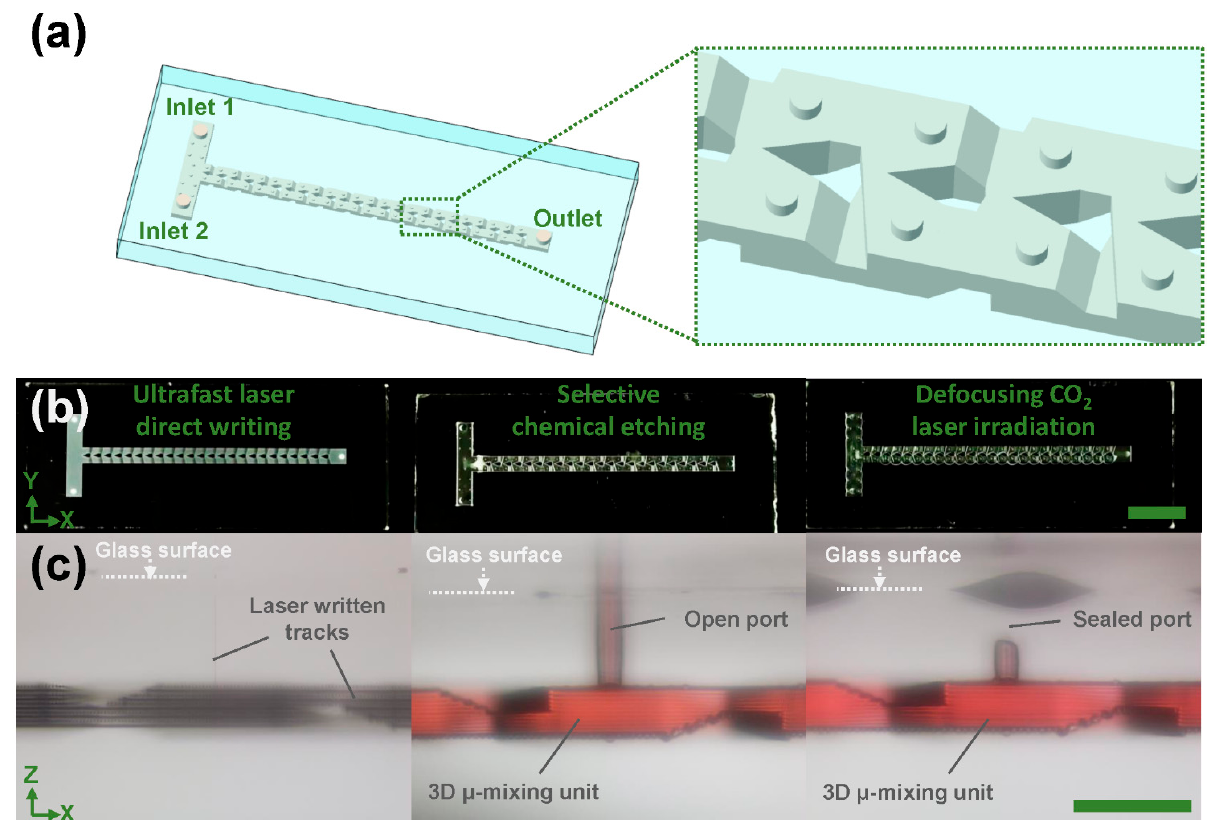
Figure 4. ( a ) Schematic of a centimeter-scale micromixing glass chip. Inset shows a close-up view of 3D micromixing units indicated by a dashed rectangle in the chip. ( b ) Photos of the glass chip at each fabrication step. Left: ultrafast laser direct writing; Middle: selective chemical etching; Right: Defocusing CO 2 laser irradiation. Scale bar represents 1 cm. ( c ) Cross-sectional optical micrographs of a 3D micromixing unit connected with an extra-access port at each fabrication step as described in ( b ). Left: laser written tracks; Middle: a 3D micromixing unit with an open port; Right: a 3D micromixing unit with a sealed port. The red color in ( c ) was the dye solution filled inside the channel, indicating the microfluidic function of the channel. Scale bar represents 1